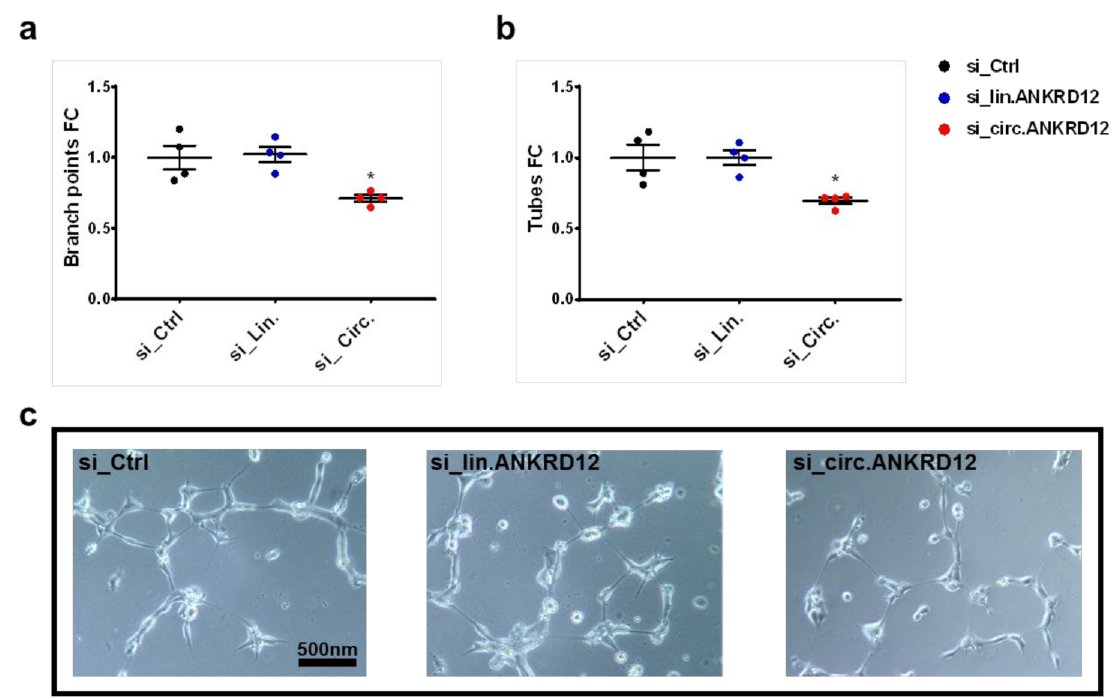
Figure 6. circANKRD12 knockdown decreases the formation of capillary-like structures. HUVEC were transfected with siRNAs specific for either the circular (si_Circ.) or the linear transcript (si_Lin.). As negative control, a non-targeting siRNA (si_Ctrl) was used. Forty-eight hours after transfection, the ability to form capillary-like structures by Matrigel assay was quantified. ( a ) Scatterplot of the number of branch points relative to control. ( b ) Scatterplot of the number of tubes relative to control. ( c ) Representative phase-contrast images of the organization into capillary-like structures for all transfections are shown. Individual values are indicated by dots, while mean and SEM are indicated by horizontal lines ( n = 3, * p <